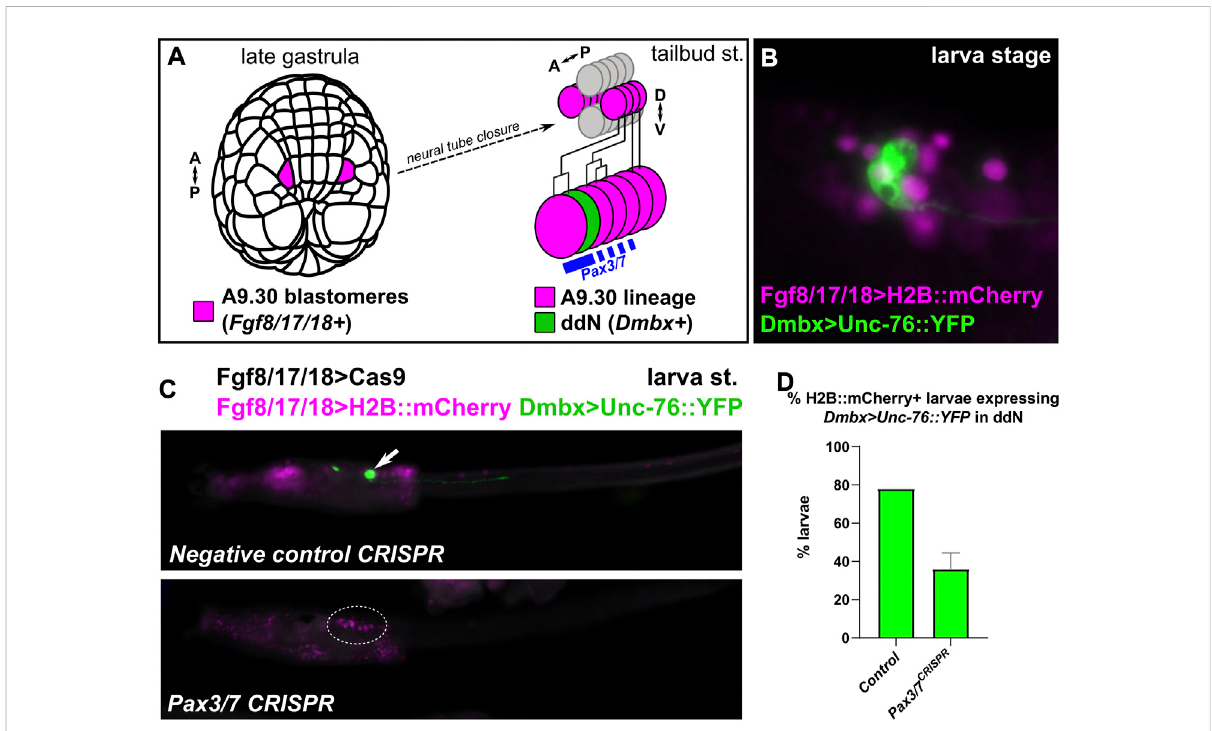
FIGURE 4 Pax3/7 CRISPRintheMotorGanglion. (A) DiagramindicatingthedescentoftheA9.30pairofblastomereswhichgiverisetothePax3/7+cellsof the anterior Motor Ganglion (MG), including the Dmbx -expressing descending decussating neuron (ddN). A – P: anterior-posterior, D – V: dorsal- ventral. (B) Larva electroporated with Fgf8/17/18 > H2B::mCherry and Dmbx > Unc-76::YFP, showing the Dmbx+ ddN cell. (C) A9.30 lineage-speci fi c CRISPR/Cas9-mediated knockout of Pax3/7 using Fgf8/17/18 > Cas9 to limit CRISPR activity to the A9.30 lineage, avoiding other territories (e.g. neural plate borders). Dmbx reporter plasmid labels ddNs (arrow) in negative control larvae, but this labeling is eliminated (dotted outline) in a large proportion of Pax3/7 CRISPR larvae. (D) Larvae at left were scored for presence/absence of Dmbx reporter expression in the ddNs. Experiment